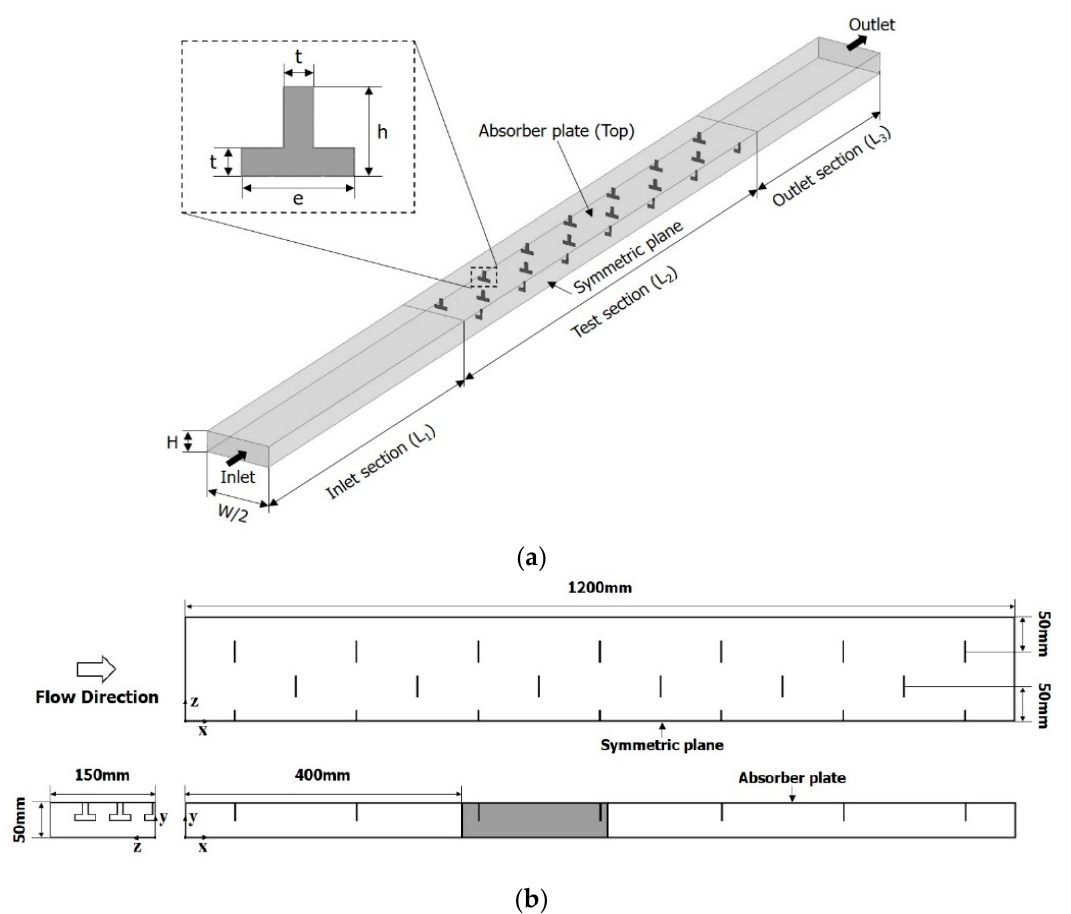
Figure 1. Computational domain of the solar air heater with T-shaped ribs. ( a ) Computational domain, ( b ) Test section.